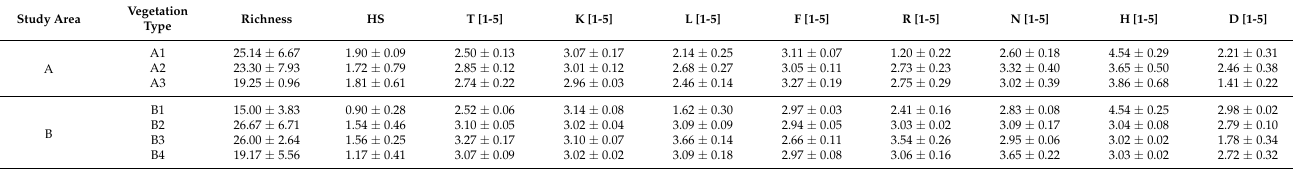
Figure 5. DCA biplots of phytosociological relevés (dots) overlapped with plant cover contour lines (blue lines with percentage of plant cover) of some diagnostic species of each cluster: Picea abies ( a ), Vaccinium myrtillus ( b ), Salix caprea ( c ) and Rubus idaeus ( d ). Key: A1, Picea abies forest; A2, Rubetum idaei ; A3, Piceo abietis-Sorbetum aucupariae . The ecological features of the three vegetation types are reported in Table 2. Cluster A2 and A3 and differ from A1 (control) by having higher values of T, L, R and N, and lower values of species richness, HS, K, and H. A3 differs from A2 by having fewer species and higher values of HS, L, and D. Table 2. Ecological features of the vegetation types of the two study areas (A, Val Malga; B, Vione): A1, Picea abies forest; A2, Rubetum idaei ; A3, Piceo abietis-Sorbetum aucupariae ; B1, Picea abies forest (of area B); B2, Astrantio-Corylion avellanae ; B3, Brachypodium rupestre-Astragalus glycyphyllos community; B4, Rubetum idaei (of area B). Key: HS, Shannon diversity index; T, temperature; K, continentality; L, light intensity; F, soil moisture; R, substrate reaction; N, nutrients; H, humus; D, aeration.